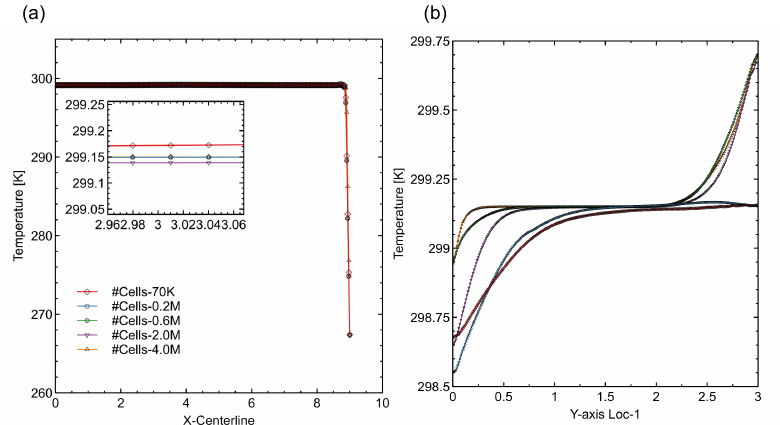
Figure A2. Grid independence study for 3D numerical computation: ( a ) Temperature profile compar- ison of various grids on x-centerline; ( b ) temperature profile comparison of various grid along y-axis close to the cabinet in the 3D